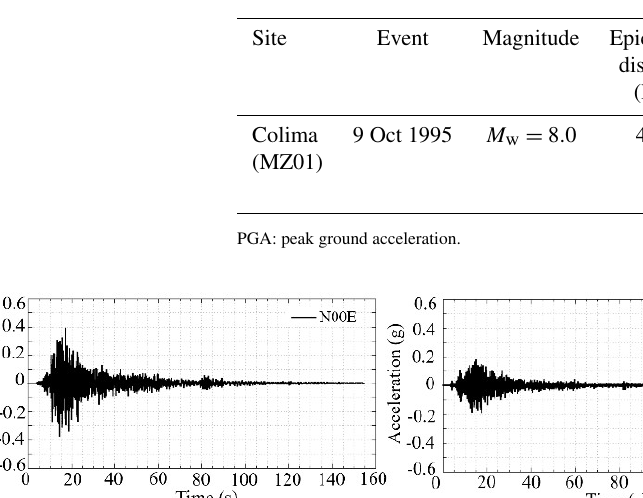
Table 1. Characteristics of the 1995 Manzanillo earthquake and the MZ01 station record.